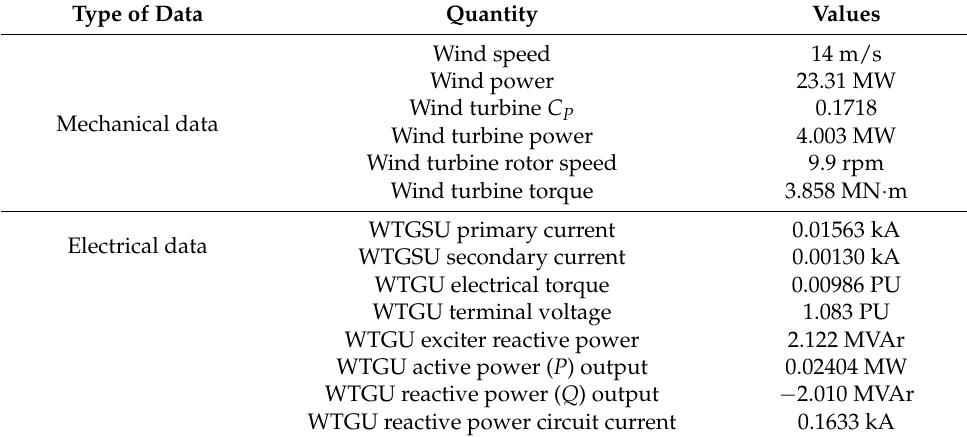
Table 6. Wind turbine generator unit monitoring at steady-state power